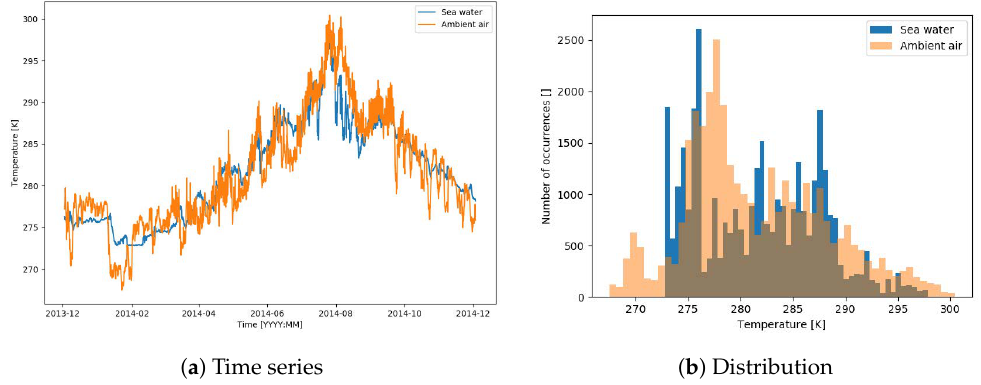
Figure 6. Measured air and sea water temperatures based on yearly data for the investigated period of ship operations. Landsort, 2014.